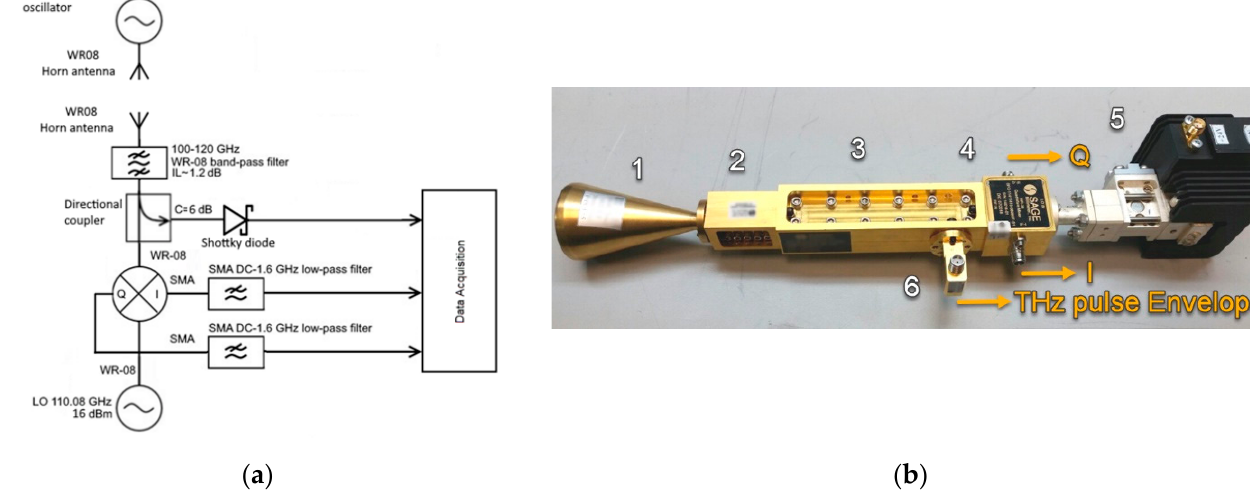
Figure 1. Mm-wavelength heterodyne spectrometer scheme ( a ) and the prototype developed by RadiaBeam ( b ). 1–30 dB horn antenna, 2—Band-pass filter, 3—Directional coupler, 4—IQ-mixer, 5—Local oscillator, 6—Schottky amplitude detector.